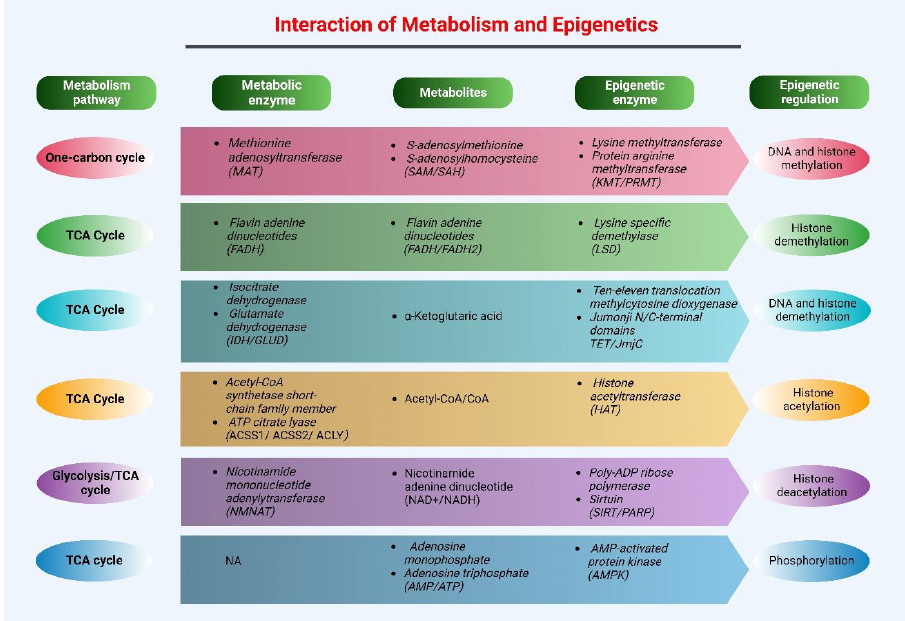
Figure 3. Summary of the major interaction between metabolism and epigenetics. (Concept